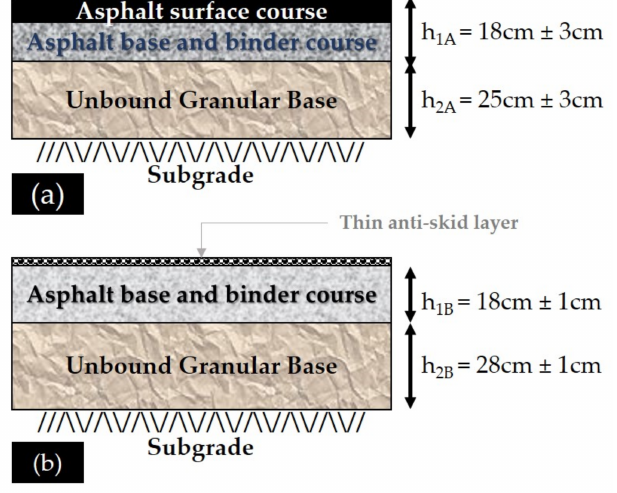
Figure 1. Typical cross-sections: ( a ) Pavement A and ( b ) Pavement